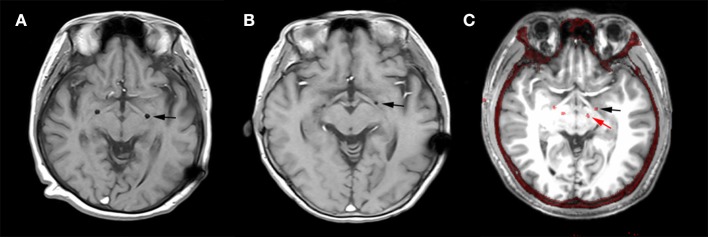
Deep brain stimulation (DBS) lead locations. Representative examples of lead locations in the left (L)-GPi of patients H2 and H6 and in both L-STN and L-GPi of patient H7 derived from post-operative MR and merged post-operative CT with pre-operative MRI. The black asterisk represents the location of GPi and the red asterisk represents the location of STN. (A) Post-operative MR showing the lead location in GPi of patient H1 on the horizontal plane. (B) Post-operative MR showing the lead location in GPi of patient H2 on the horizontal plane. (C) Merged image showing the lead locations in GPi and STN of patient H7 on the horizontal plane.